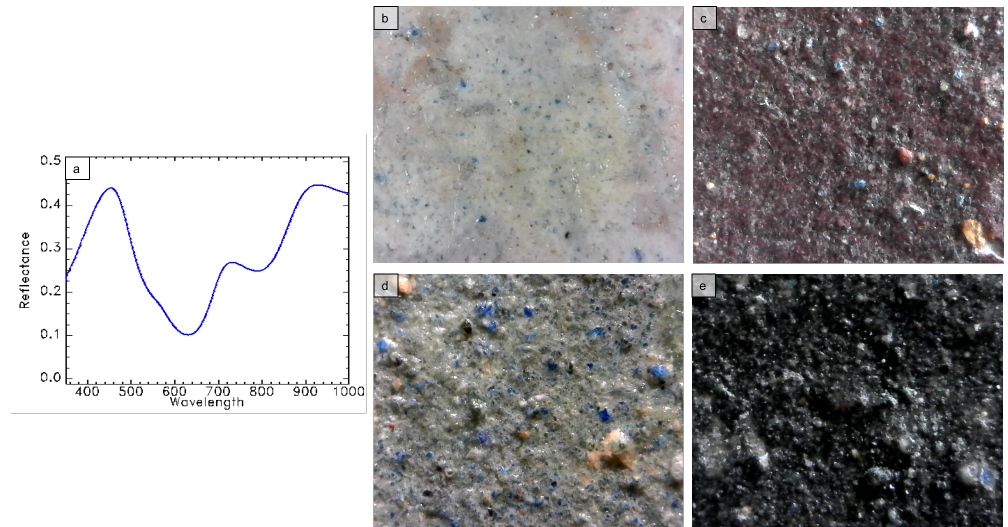
Figure 11. ( a ) Reflectance spectrum of Egyptian blue, featuring characteristic absorptions at 560, 630, and 790 nm. Photomicrographs (250x) of different wall painting fragments containing Egyptian blue: ( b ) Egyptian blue in a white paint (E5); ( c ) Egyptian blue in a purple paint mixed with hematite (E5); ( d ) Egyptian blue and green earth mixture applied over yellow ochre (N2); ( e ) Egyptian blue in a black paint